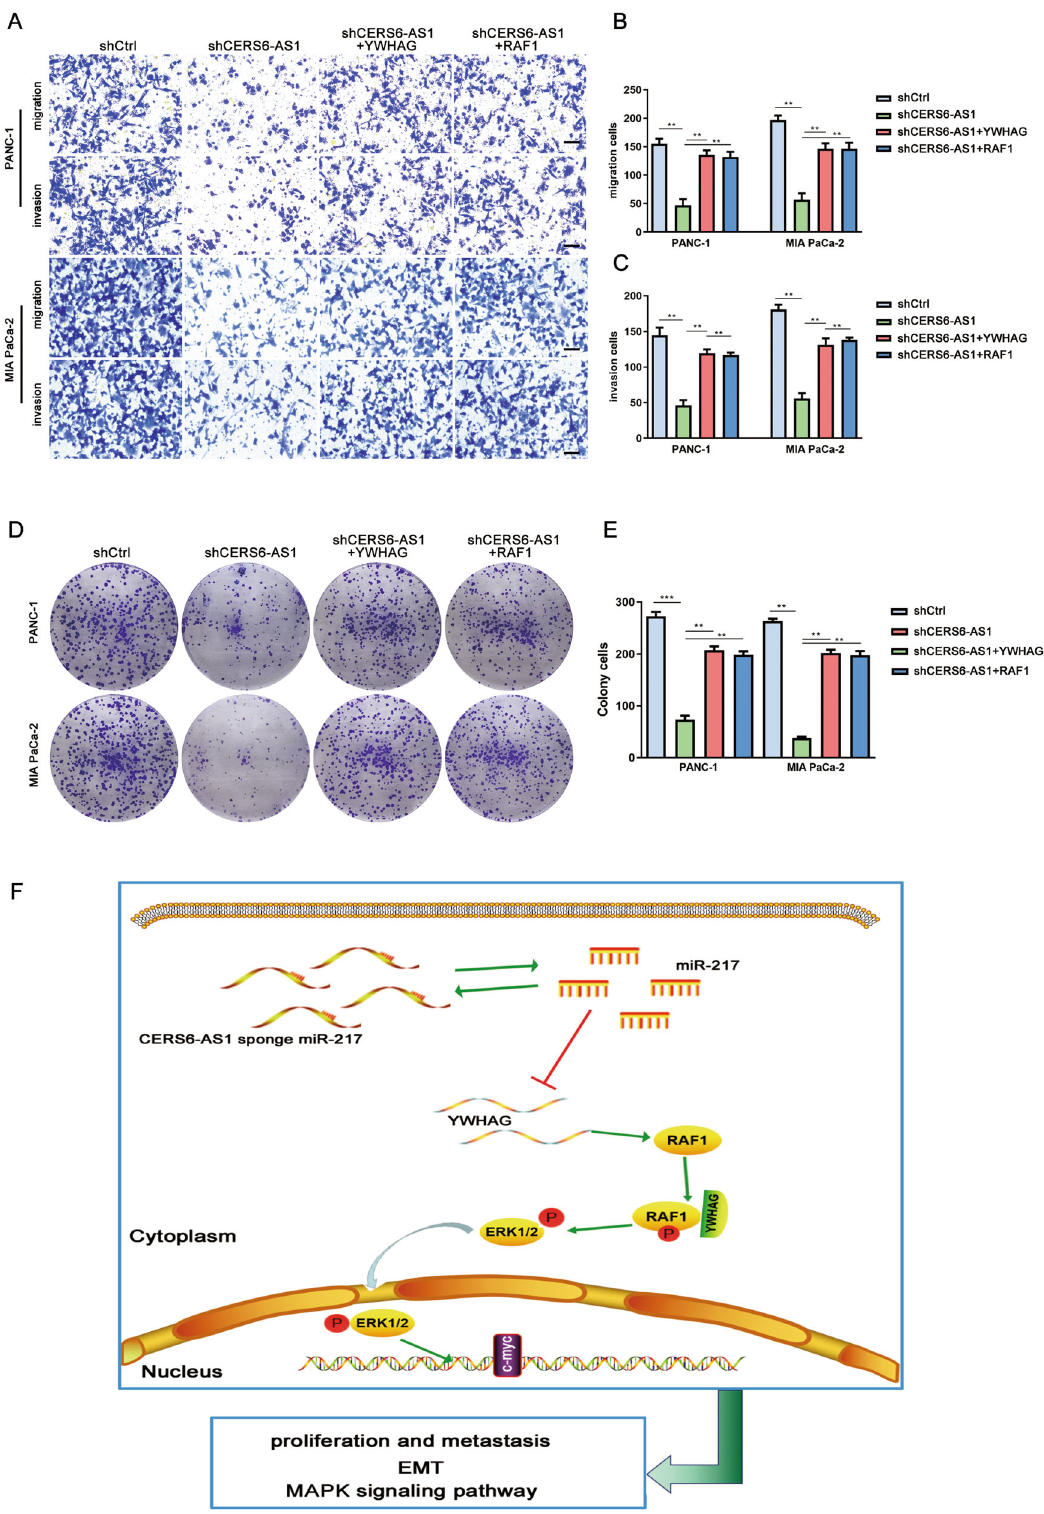
Fig. 7 CERS6-AS1 promotes PC cell proliferation and metastasis by activating ERK signaling via miR-217/YWHAG/RAF1 axis. A – C Functional rescue experiments were performed to validated migration and invasion in shCERS6-AS1 + YWHAG and shCERS6-AS1 + RAF1 groups compared to shCRES6-AS1 group (scale bar: 100 μ m). D , E Functional rescue experiments were performed to validated proliferation in shCERS6-AS1 + YWHAG and shCERS6-AS1 + RAF1 groups compared to the shCRES6-AS1 group. F The schematic diagram is used to elucidate the underlying molecular mechanism that CERS6-AS1 promotes PC metastasis and proliferation and indirectly upregulates YWHAG and phosphorylates of RAF1 to activate ERK signaling by decoying miR-217.